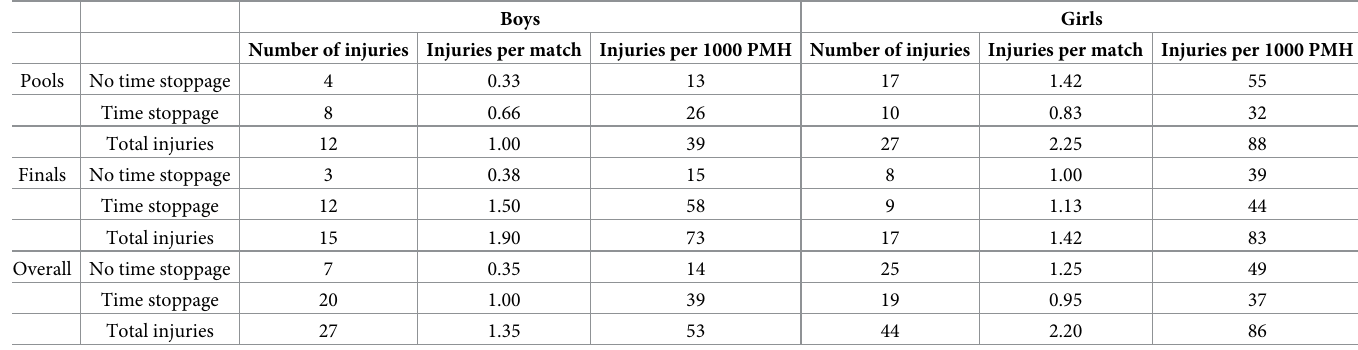
Table 1. Total number of injuries, injuries per match, and injuries per 1000 player match hours (PMH) in boys’ and girls’ competitions. Boys